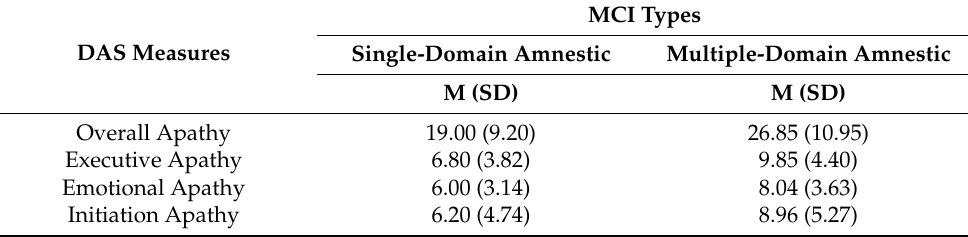
Table 5. Apathy measures of the different MCI